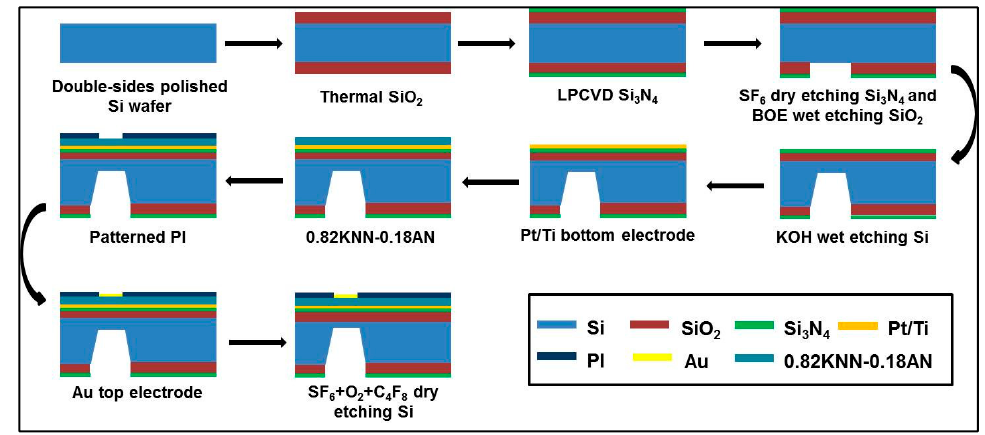
Figure 10. Schematic fabrication process of the piezoelectric diaphragms.